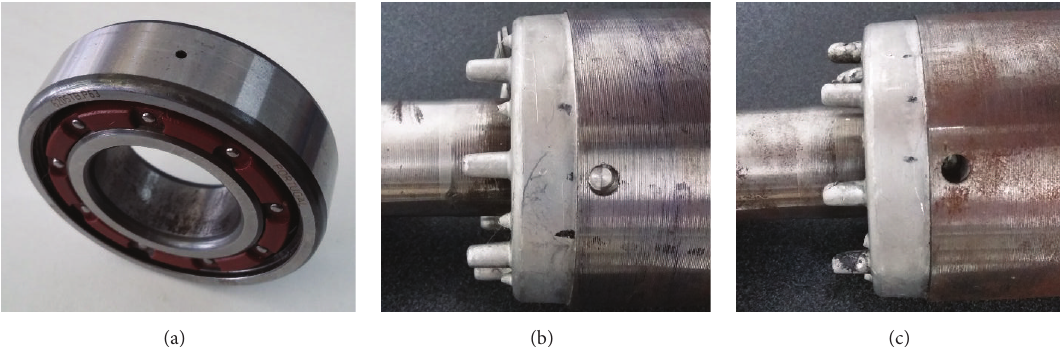
Figure 5: Detail of the failures produced in the test bench. (a) corresponds to the bearing failure, BF. (b) corresponds to the 1/2 -broken rotor bar, HBRB, and (c) to 1 broken rotor bar, FBRB.